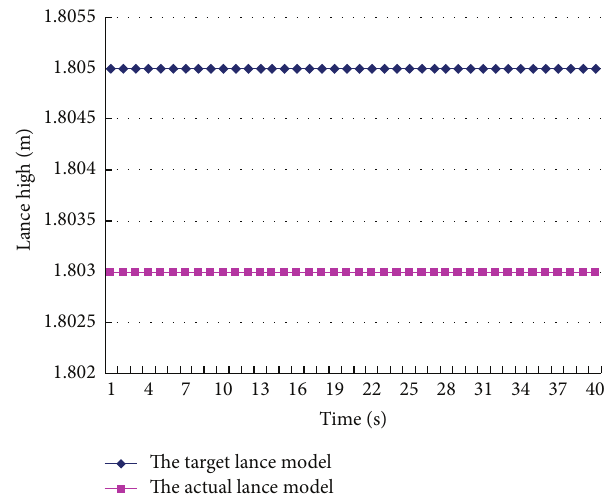
Figure 6: Dynamic curves between the actual lance mode and the target lance mode.